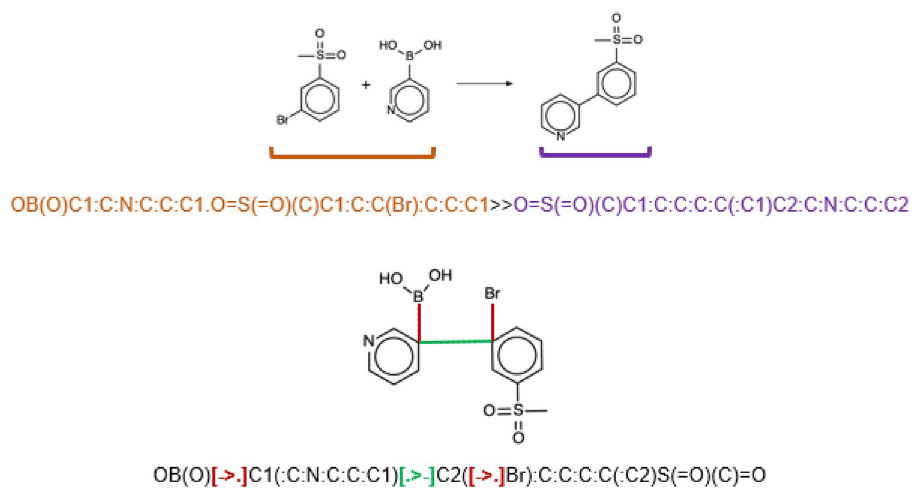
Figure 1. An example of Suzuki coupling reaction ( top ) and its condensed graph (CGR, bottom ). Reaction SMILES and SMILES/CGR are given underneath. The reaction SMILES features reactants (in orange), and products (in purple). Atom-to-atom mapping is not provided. In the SMILES/CGR broken single bonds are encoded as [- > .] (in red), while the created C–C bond is [. > -] (in green). The colon (:) represents aromatic bonds. See Supporting Information for the